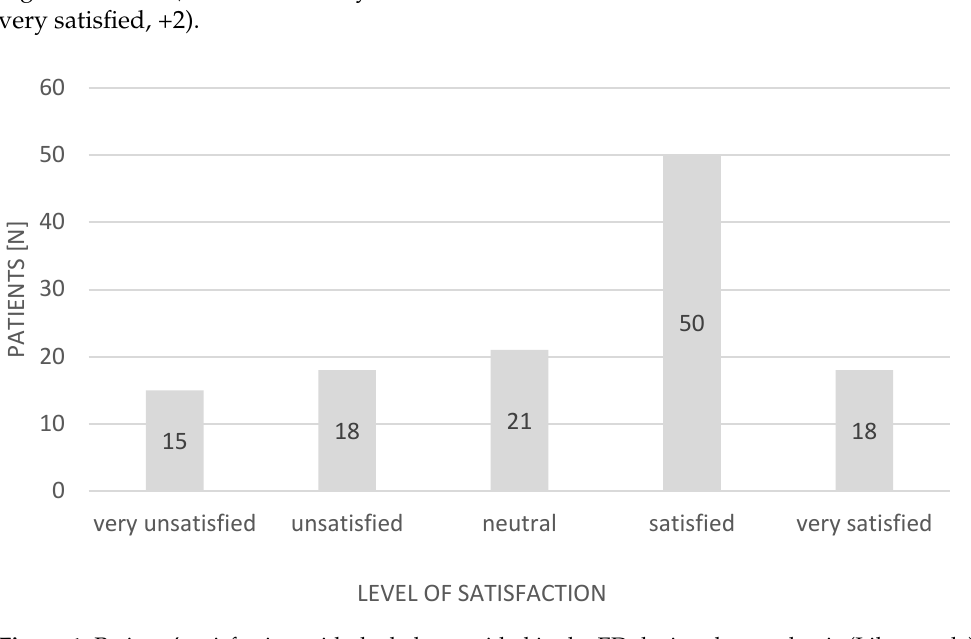
Figure 1. Patients’ satisfaction with the help provided in the ED during the pandemic (Likert scale).